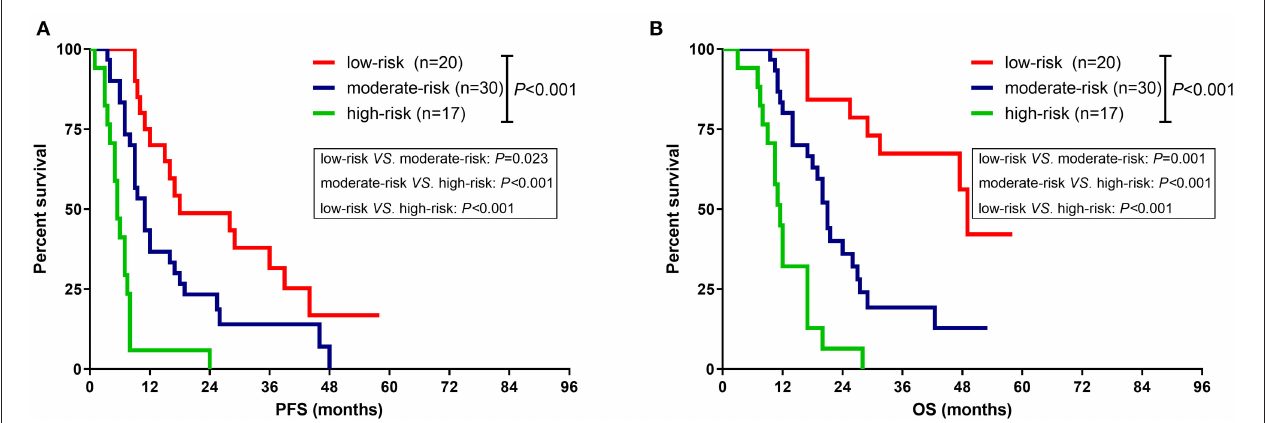
FIGURE 4 | Comparison of survival rate between different subgroups based on the prognostic scoring scale. (A) The median PFS for patients in low-risk, moderate-risk and high-risk groups was 18.0, 11.0, and 5.5 months, respectively, which imparted a significant difference ( P < 0.001). (B) The median OS for patients in low-risk, moderate-risk and high-risk groups was 49.0, 21.0, and 11.5 months, respectively, which imparted a significant difference ( P < 0.001).